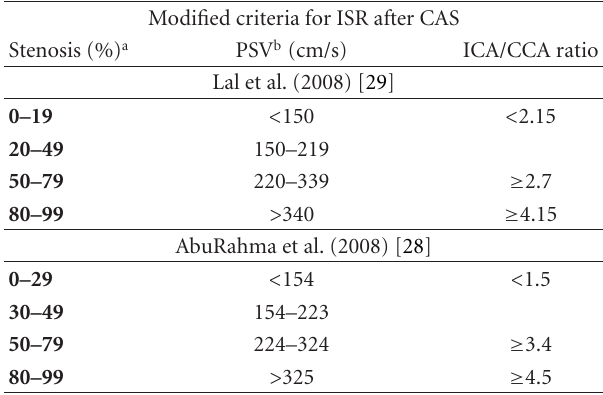
Table 4: Comparison of modified criteria for ISR after